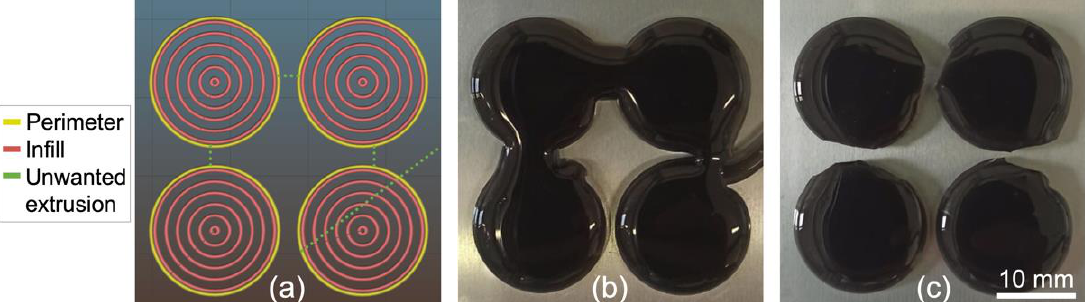
Figure 9. Printing of a sequence of four discs with a concentric infill pattern and 28% infill density. ( a ) Printing path generated in Slic3r; ( b ) corresponding print; and ( c ) print after removal of the unwanted extrusion. Silicone: Ecoflex 00-50 with black dye. Needle diameter: 1.6 mm. Printing speed: 10 mm/s. Extrusion speed: 0 mm/s. Bed temperature: 90 °C.